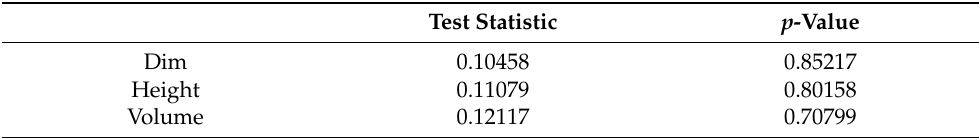
Table 4. Test statistics and p -value tests.